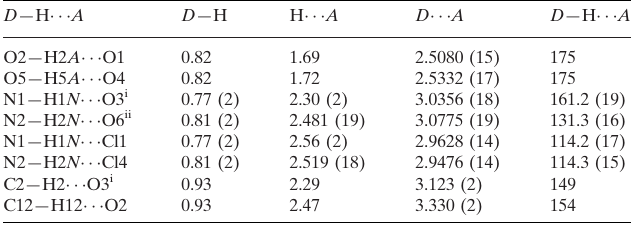
Hydrogen-bond geometry (A˚ , (cid:3) ).